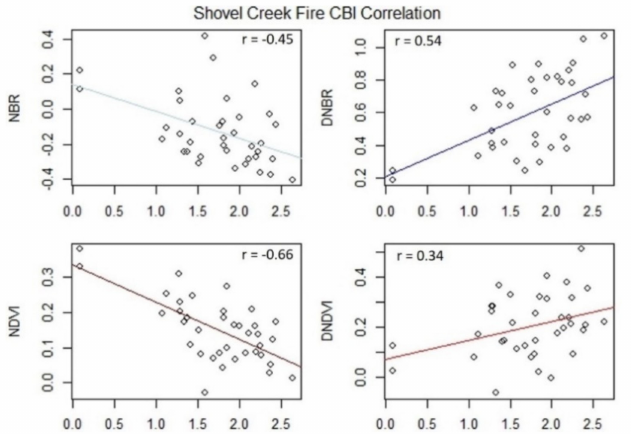
Figure 6. Correlation between the CBI values and indices with Pearson correlation coefficients for the Shovel Creek fire